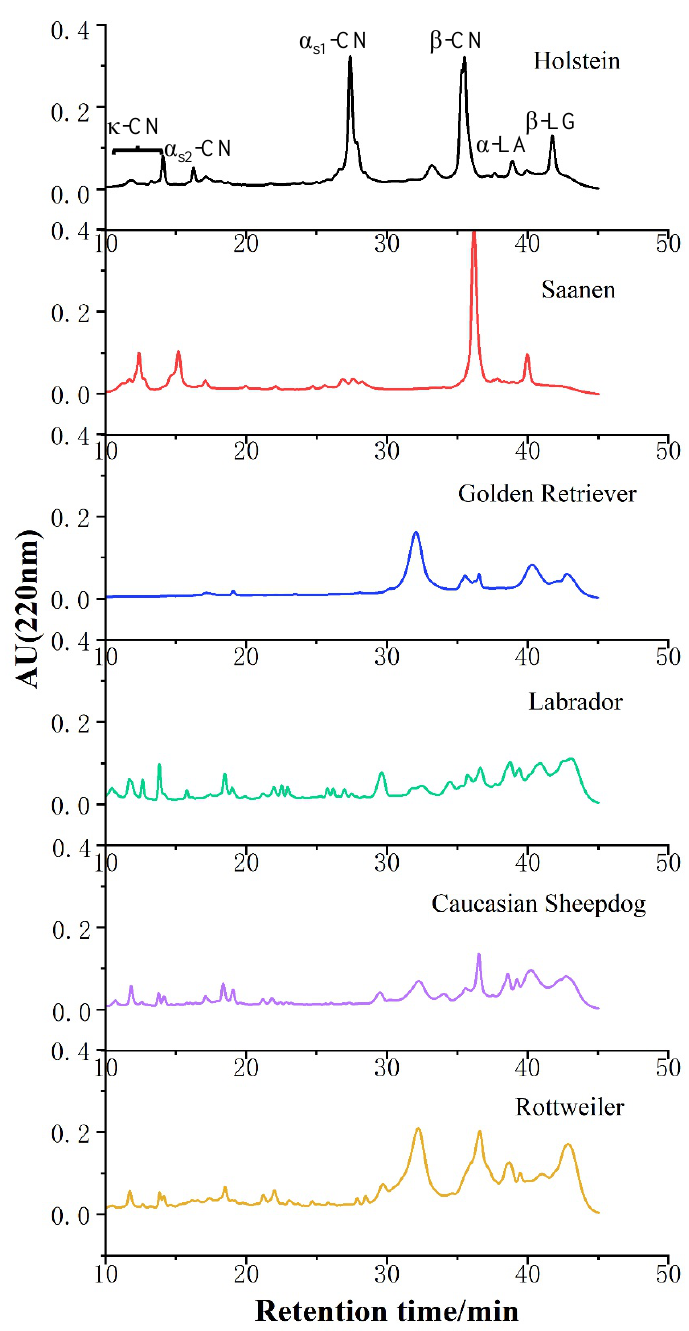
Figure 2. Reverse phase high-performance liquid chromatography chromatograms of protein frac- tions in canine, bovine, and caprine milk. α s1 -CN: α s1 -casein, α s2 -CN: α s2 -casein, β -CN: β -casein, κ -CN: κ -casein, β -LG: β -lactoglobulin, α -LA: α